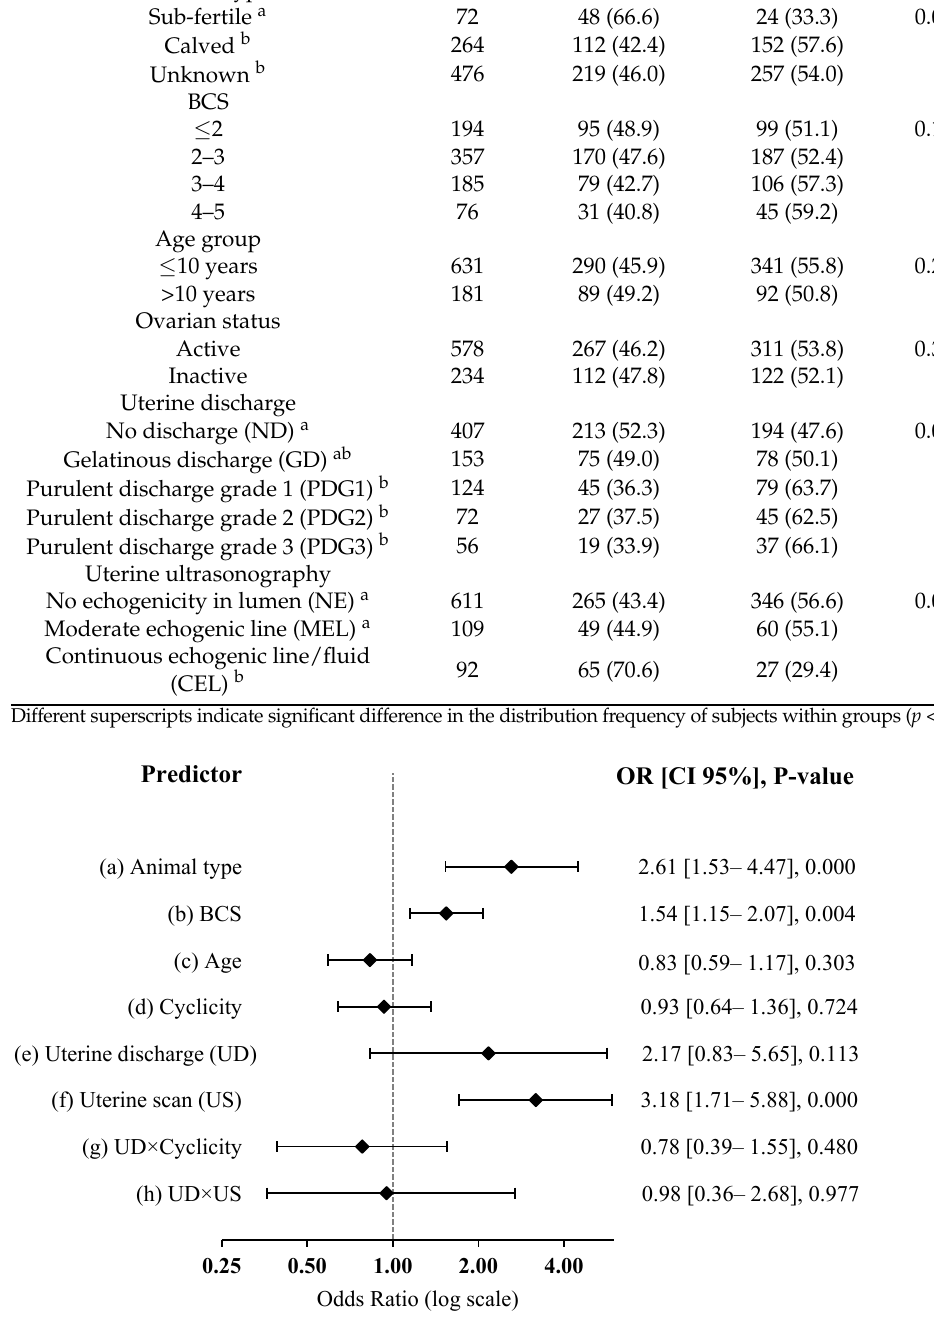
Figure 3. Graphical presentation of the association between clinical measures and the odds of bacterial isolation from the uterus in dromedary camel. (a) subfertile vs. calved and& unknown; (b) BCS < 3 vs. BCS ≥ 3; (c) Age ≤ 10 y vs. Age > 10 y; (d) active ovary (AO) vs. inactive ovary (IO); (e) no discharge and gelatinous discharge (ND) vs. purulent discharge (PD); (f) consistently echogenic appearance (CE) vs. non-echogenic and mild-echogenic appearance (NE); (g) ND × AO vs. PD × IO; (h) ND × CE vs. PD × NE.